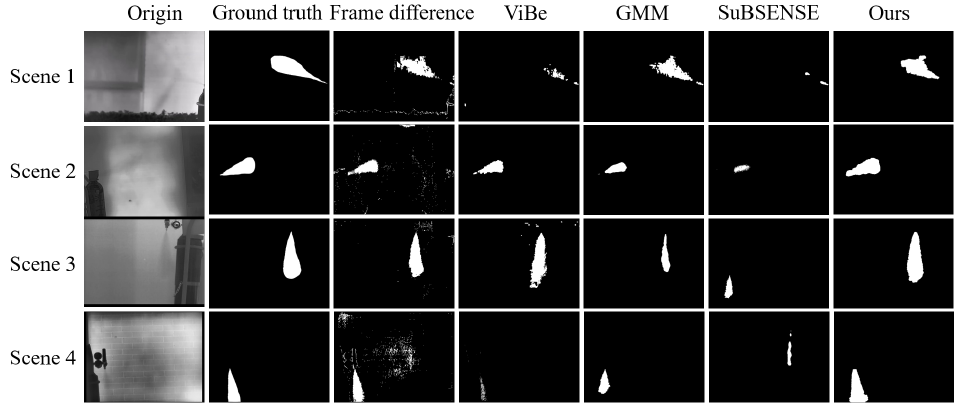
Figure 10. Comparison of detection results of different frame algorithms in the scene.